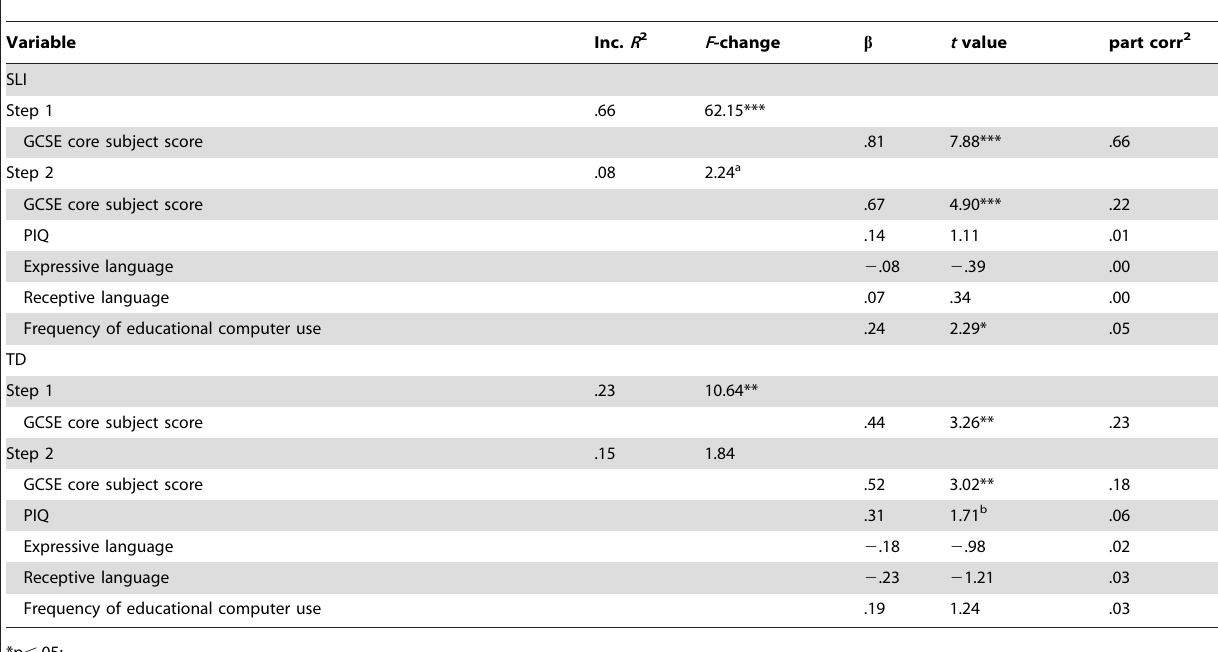
Table 5. Hierarchical regression analysis predicting level of educational progress separately for young people with SLI and TD peers continuing in post-compulsory